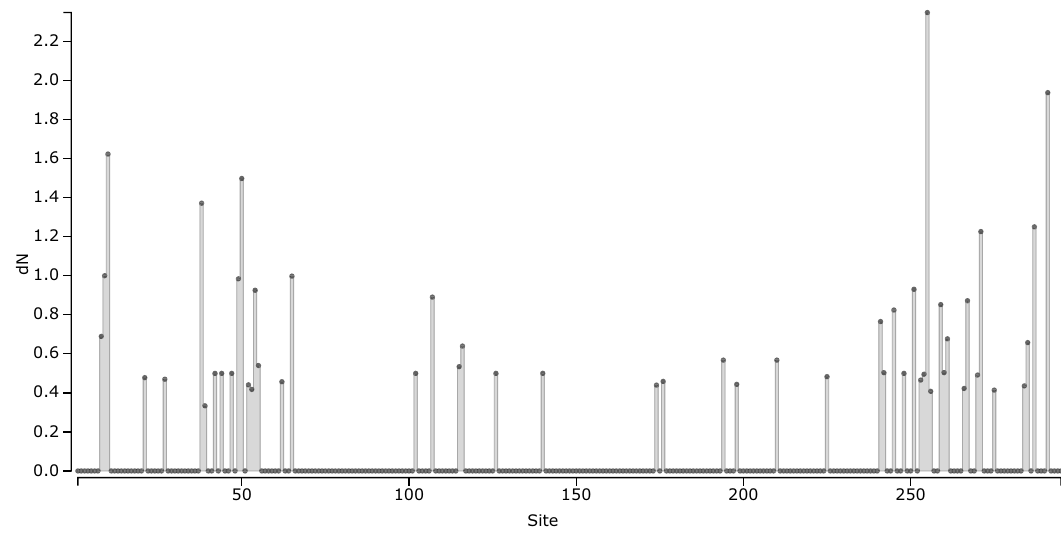
Figure 4. Number of non-synonymous substitutions per non-synonymous site among B. calyciflorus s.s. and B. fernandoi HSP 40 kDa for each amino acid alignment position of the 32 different HSP 40 kDa alleles.